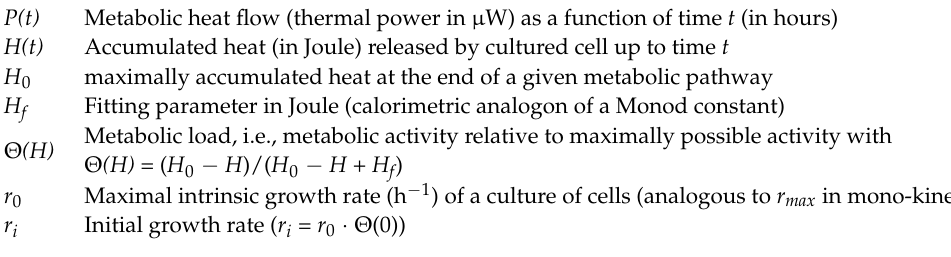
Figure S4: Estimated amount of cell-associated uranium after exposure of B. napus cells. Figure S5: Thermograms of Lysinibacillus sphaericus strain